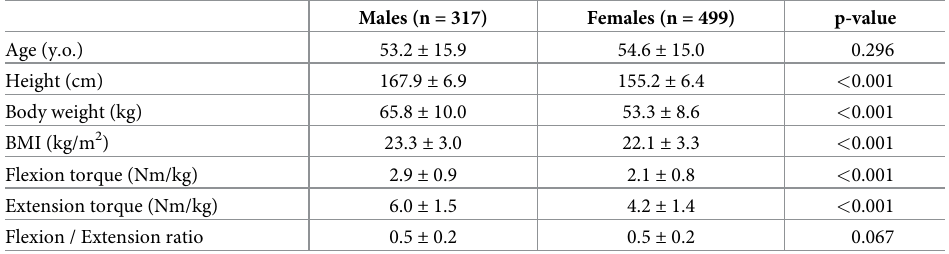
Table 2. Demographic data for participants in study 2. Males (n = 317) Females (n = 499) p-value Age